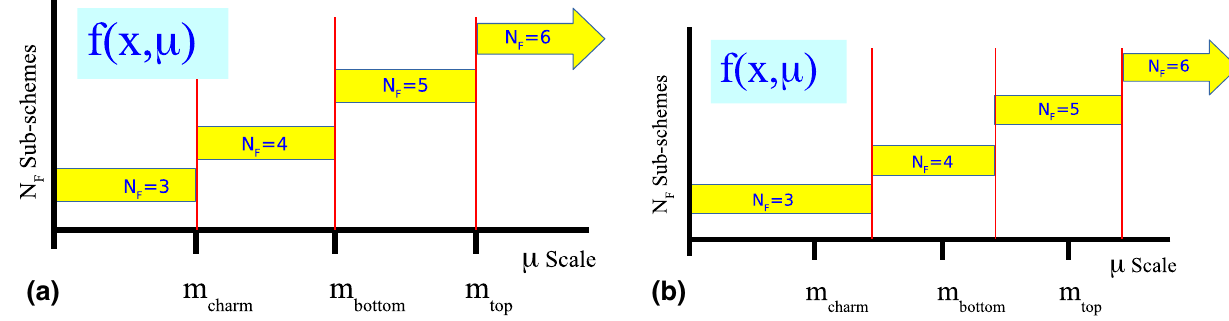
Fig. 1 An illustration of the separate N F renormalization sub-schemes which define a VFNS. Historically, the matching scales μ m were chosen to be exactly the mass values m c , b , t as in a . b Generalized case where the matching scales μ m are chosen to be different from the mass values necessarily continuous. This scheme has N F = 5 active fla- vors { u , d , s , c , b } , and the bottom quark is included in the DGLAP